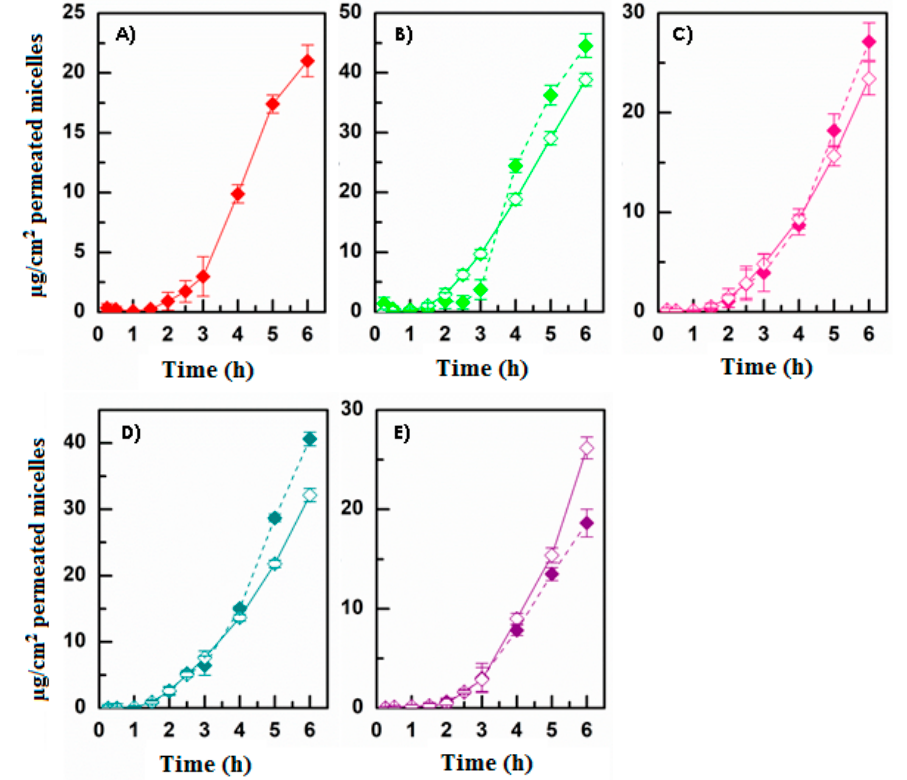
Figure 4. Ex vivo permeation studies: μ g/cm 2 of fluorescent labeled micelles permeated as a function of incubation time after administration of enhancer-functionalized micelles (solid symbols) or co-administration of INU-EDA-RA micelles with the enhancer solutions (open symbols). ( A ) INU-EDA-RA (red), ( B ) INU-EDA-RA-PEG and INU-EDA-RA + PEG solution (green), ( C ) INU-EDA-TAU-RA and INU-EDA-RA + TAU solution (pink), ( D ) INU-EDA-RA-CAR and INU-EDA-RA + CAR solution (petrol green), ( E ) INU-EDA-RA-CRE and INU-EDA-RA + CRE solution (violet). Significance: p < 0.05.